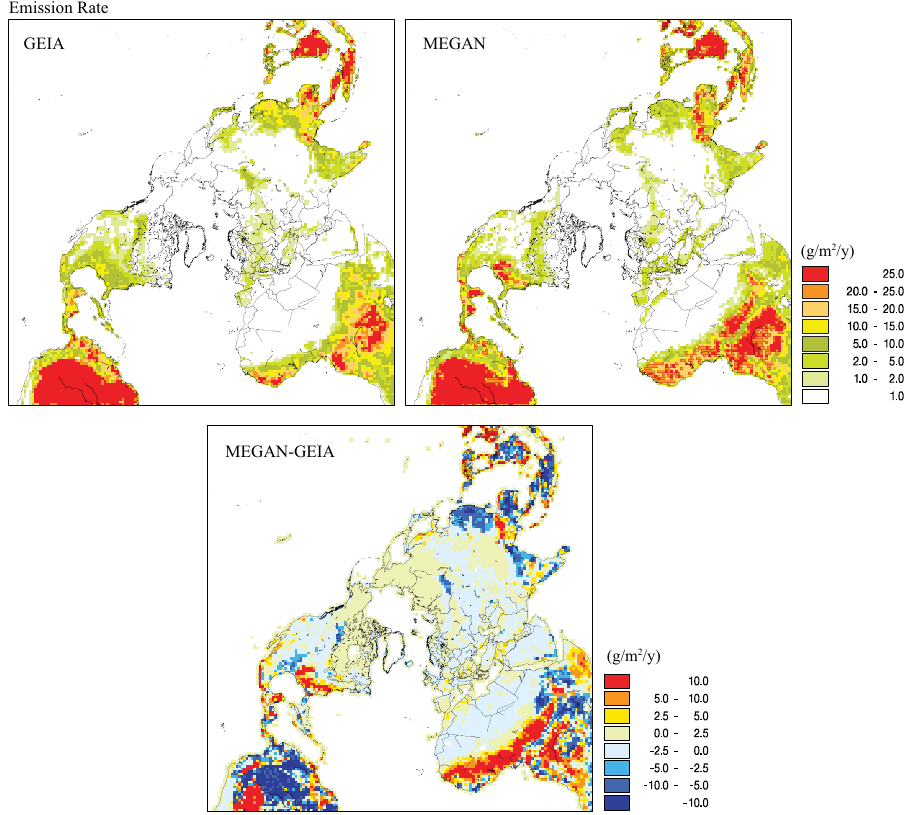
Fig. 1. Spatial distribution of the annual isoprene emission rates (g isoprene m − 2 yr − 1 ) calculated with GEIA and MEGAN, together with their difference for 2006.